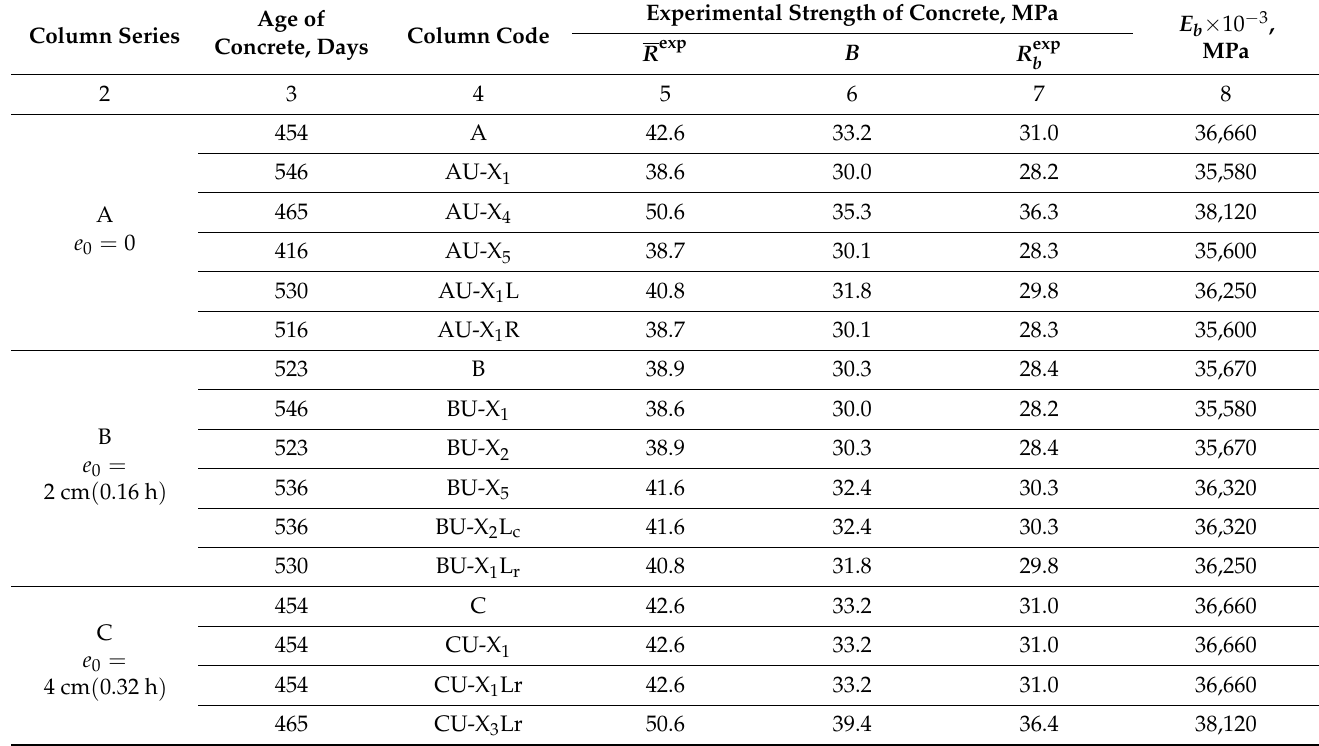
Table 3. Reinforcement variants and concrete strength characteristics of